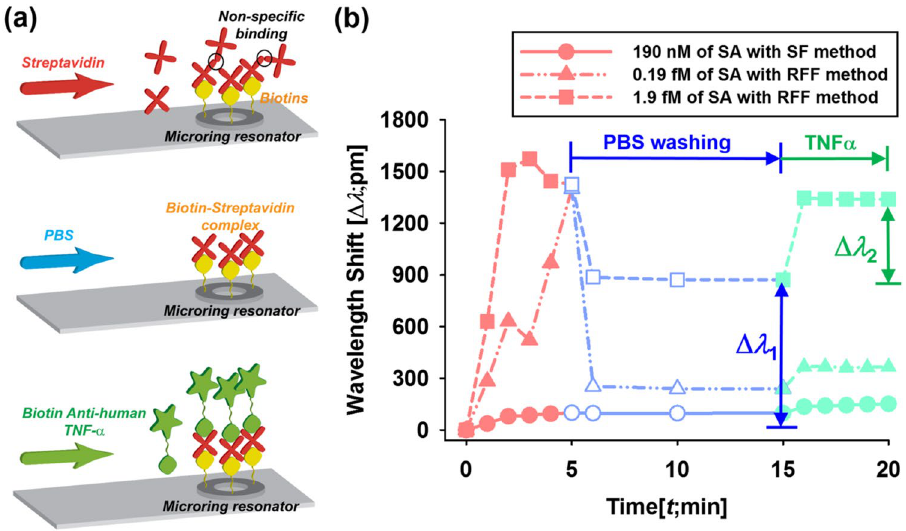
Figure 6. ( a ) Schematic diagram of experimental procedures to investigate the biological activity of conjugated Streptavidin to immobilised biotins onto a microring resonator by injecting Streptavidin solution, PBS and biotin-TNFα solution and ( b ) the binding curves of the biotin-Streptavidin interaction using various concentrations of Streptavidin solutions (red line; 0–5 min) with different flow methods (solid line; 190 nM Streptavidin solution with SF method, dot double-dashed line; 0.19 fM Streptavidin solution with RFF method and dashed line; 1.9 fM Streptavidin solution with the RFF method) followed by PBS washing (blue line; 5–15 min) and subsequent interaction between bound Streptavidin and biotin-TNFα (green line; 15–20 min).